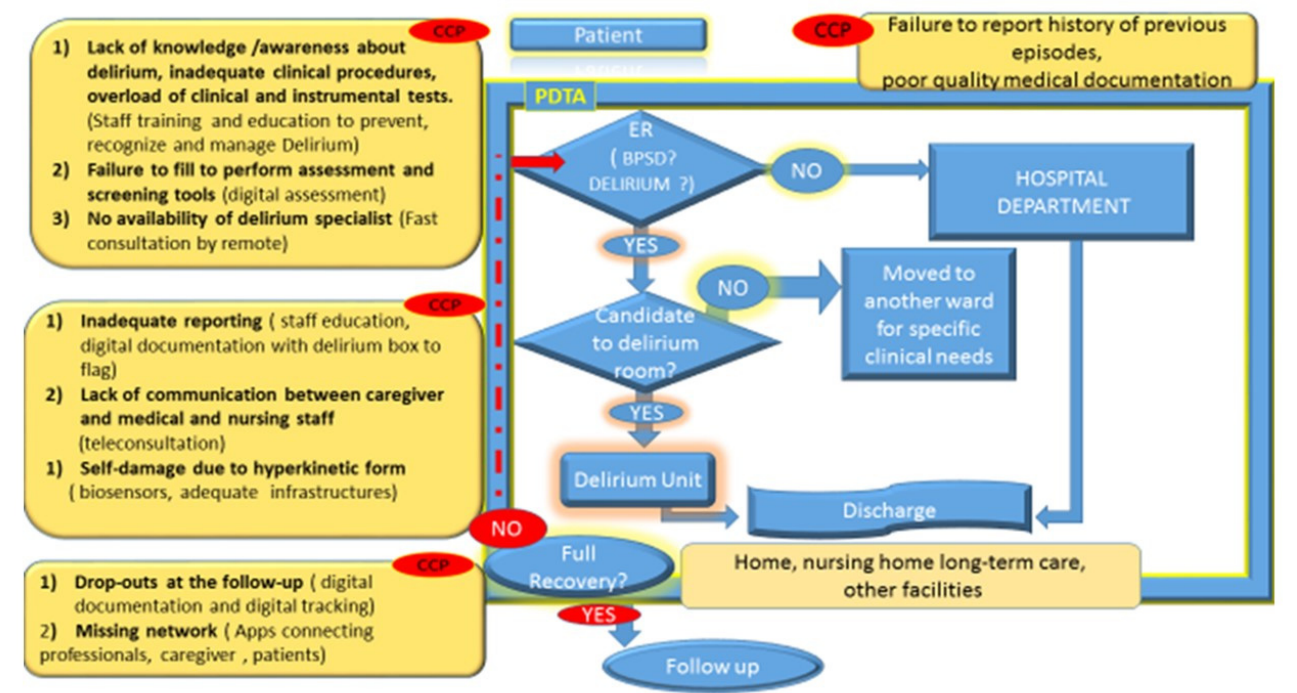
Figure 3. In a highly organized healthcare organization that is equipped with a delirium unit, within a well-codified PDTA (pathway for diagnosis, treatment, and assistance), delirium care management is characterized by several CCPs (critical clinical points). In the boxes, we report what the CCPs are and the criticism about what is the actual practice by suggesting possible solutions in the parentheses. At hospital admission, the lack of good documentation about the vulnerability of patients increases the risk to expose the elderly to the potential contributing factors precipitating delirium. Elderly patients with behavioral disorders are at risk of being diagnosed with dementia if personnel are not trained to recognize delirium. Sometimes, delirium occurs also in younger people, and they are managed in not-appropriate settings (delirium is mistaken for psychosis). Discharge is another critical point during the “hospital delirium journey”. In the end, people affected by delirium do have not a robust supporting network and they are lost at the follow-up. Therefore, the risk of cognitive decline is not promptly addressed.